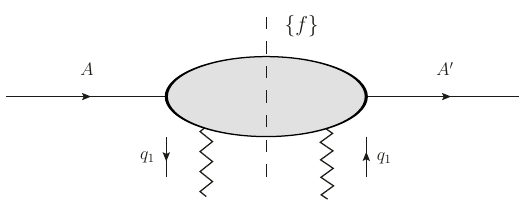
Figure 3 . Schematic description of an impact